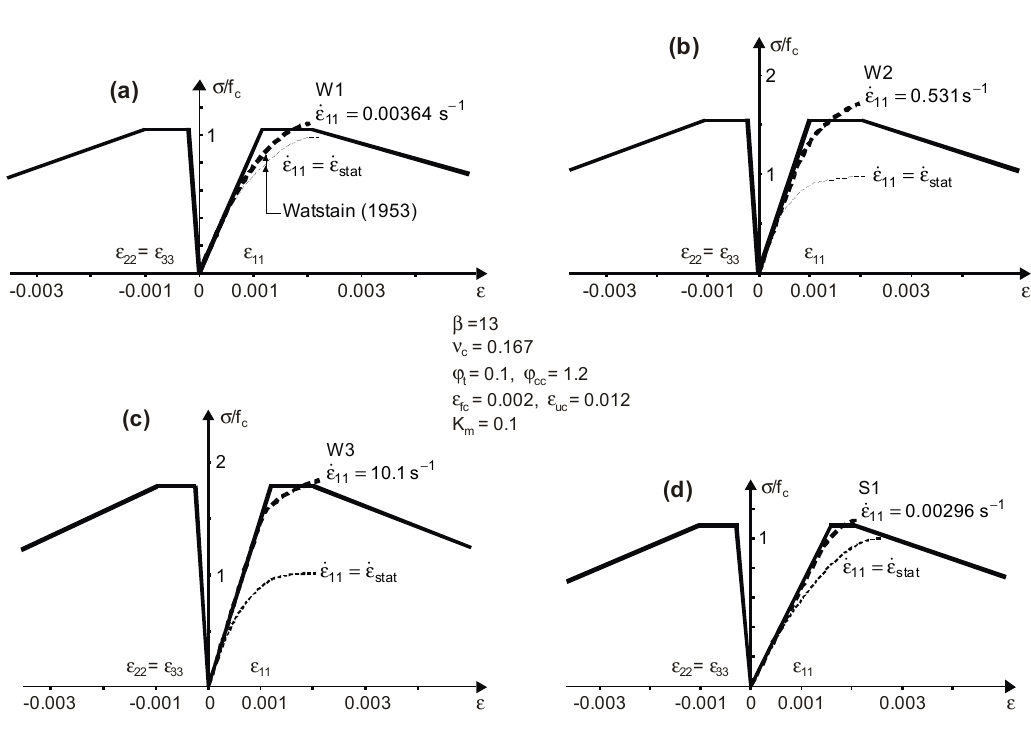
. ε = . ε = . ε = 0.00364 s − 1 ; ( b ) W2 0.531 s − 1 ; ( c ) W3 10.1 s − 1 ;